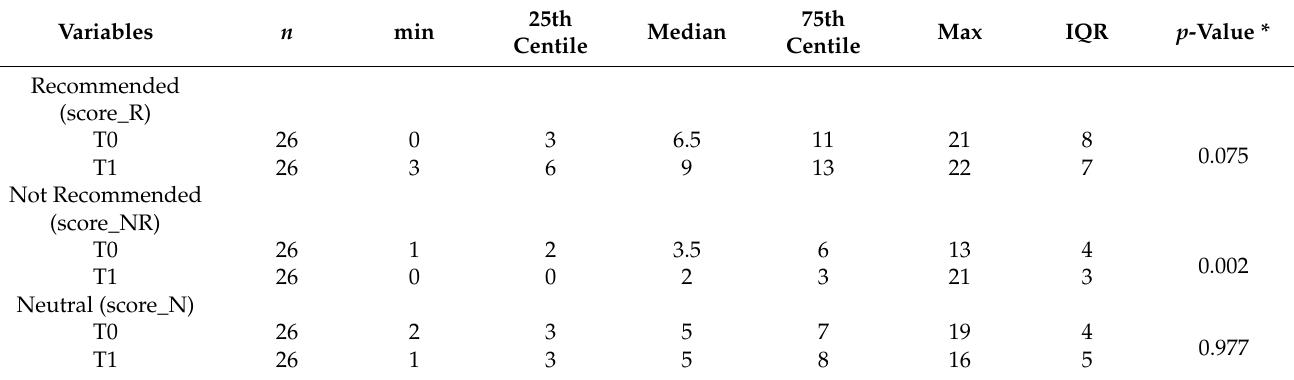
Table 1. Descriptive statistics of the three overall scores.